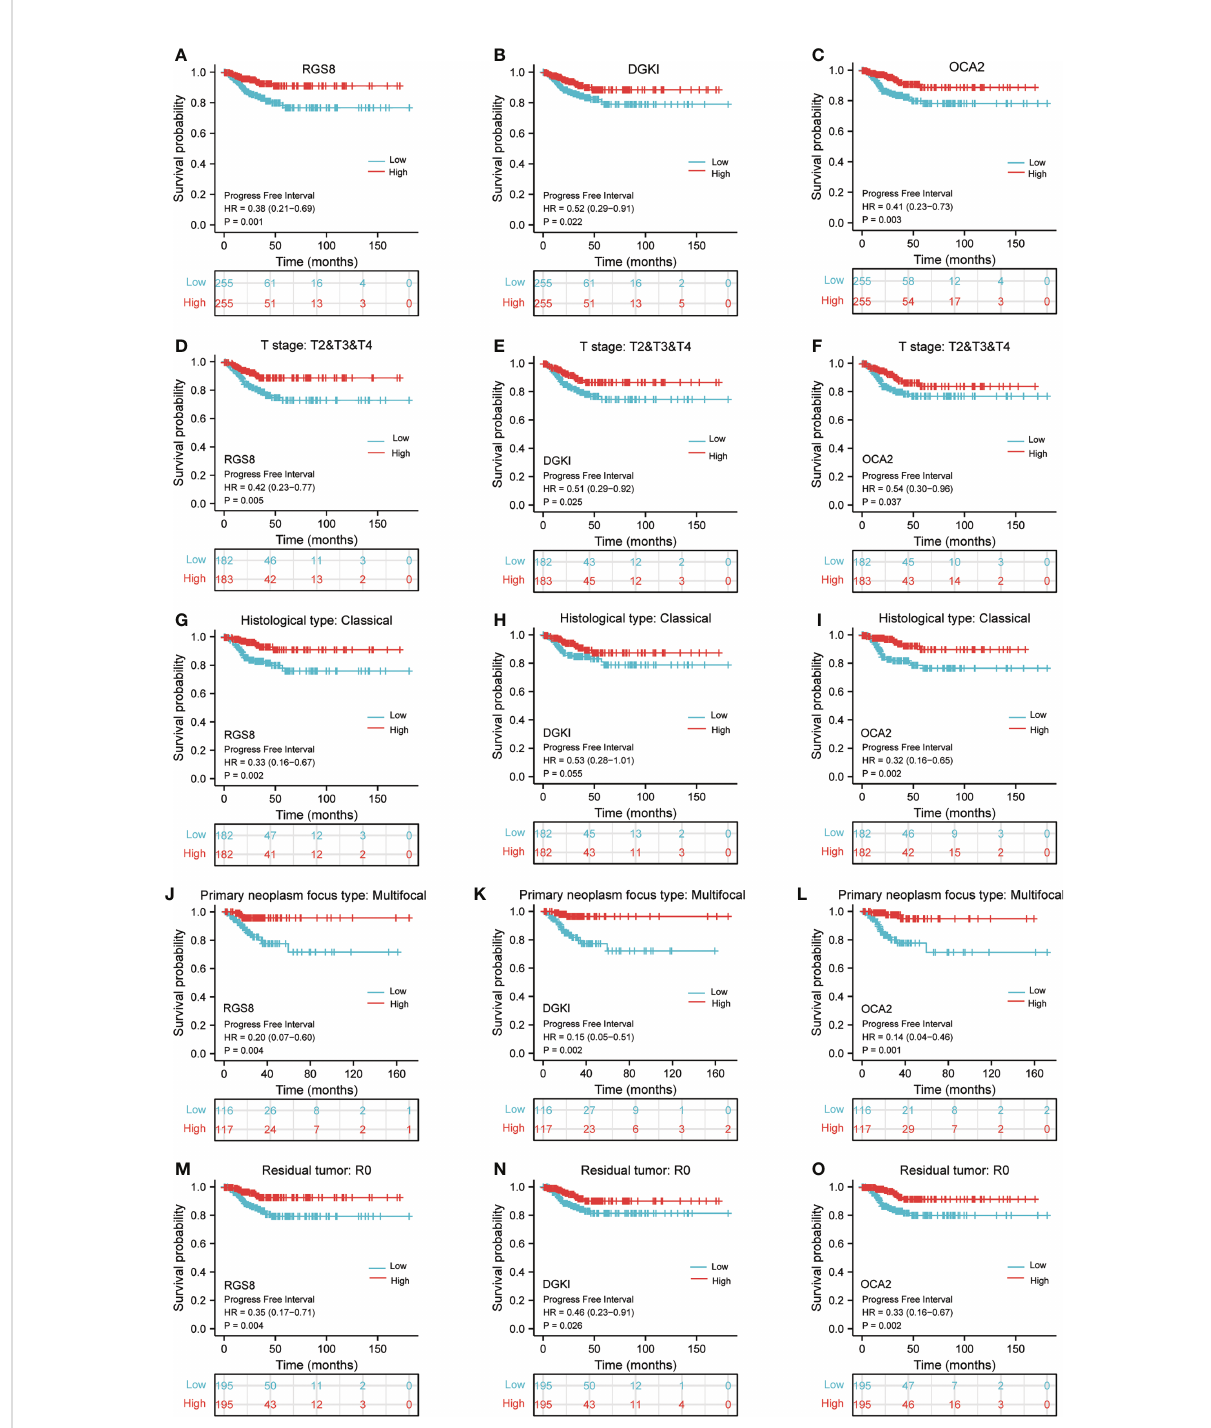
FIGURE 4 Kaplan – Meier survival plots comparing the low and high expression of RGS8, DGKI and OCA2 in THCA. PFI survival curves of patients with THCA between high and low expression of RGS8 (A) , DGKI (B) and OCA2 (C) . PFI survival curves of T stages 2, 3 and 4 between RGS8-high and -low patients (D) , DGKI-high and -low patients (E) , OCA2-high and -low patients (F) with THCA. PFI survival curves of classical histological type between RGS8-high and -low patients (G) , DGKI-high and -low patients (H) , OCA2-high and -low patients (I) with THCA. PFI survival curves of multifocal primary neoplasm focus type between RGS8-high and -low patients (J) , DGKI-high and -low patients (K) , OCA2-high and -low patients (L) with THCA. PFI survival curves of R0 between RGS8-high and -low patients (M) , DGKI-high and -low patients (N) , OCA2-high and -low patients (O) with